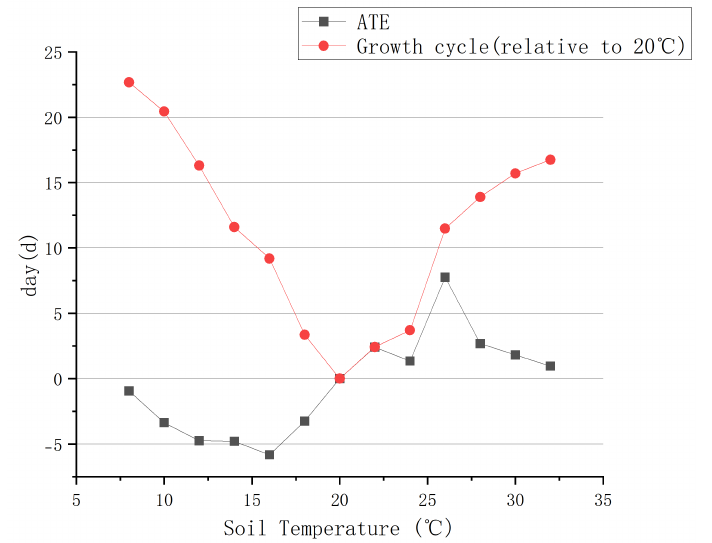
Figure 9. The causal effect of different soil temperatures on the growth of leafy greens and the effect of relative 20 ◦ C on the growth cycle.